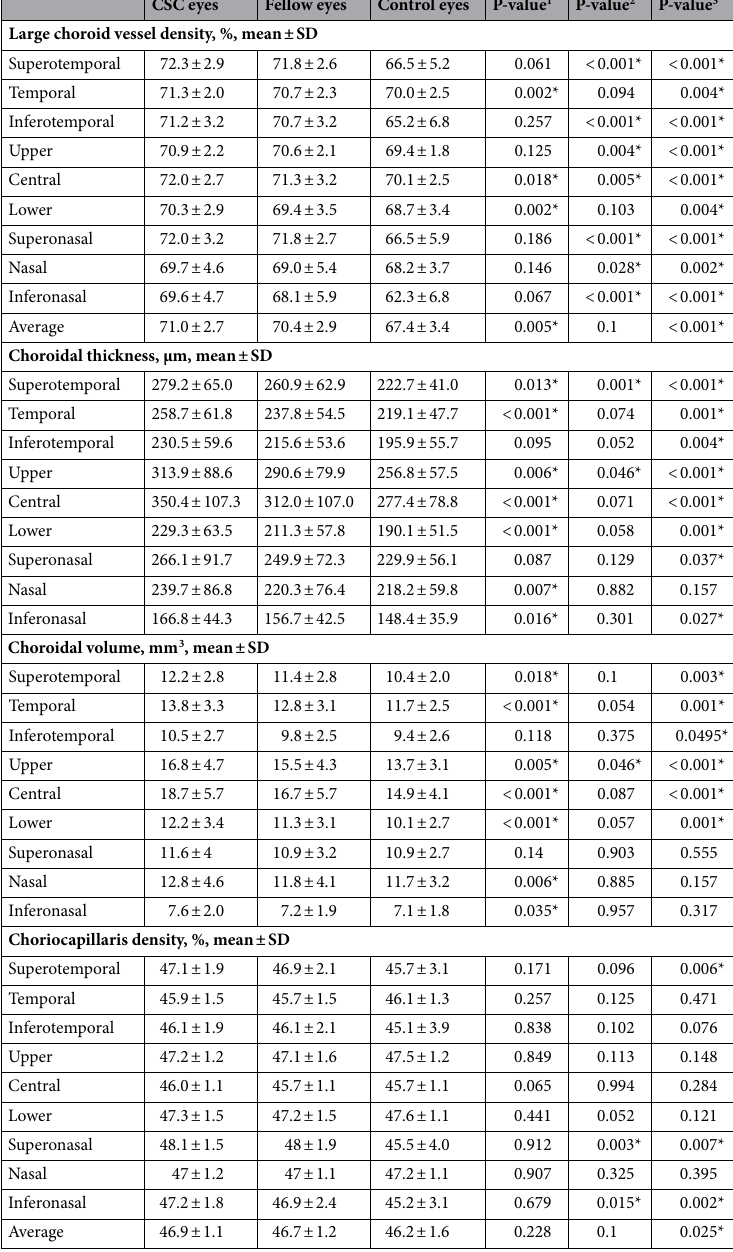
Table 3. Comparisons of choroidal vasculature in nine regions among CSC eyes, fellow eyes and healthy control eyes. Data are presented as means ± standard deviations unless otherwise indicated. 1 Comparisons of ocular factors between diseased and fellow eyes of patients with CSC were performed using the paired t test for parameters with normal distribution and using the Wilcoxon matched-pairs signed rank test for parameters with nonnormal distribution. 2 Comparisons of ocular factors between healthy eyes and fellow eyes of patients with CSC were performed using the independent t test for parameters with normal distribution and using the ManneWhitney U test for parameters with nonnormal distribution. 3 Comparisons of ocular factors between healthy eyes and diseased eyes of patients with CSC were performed using the unpaired t test for parameters with normal distribution and using the ManneWhitney U test for parameters with nonnormal